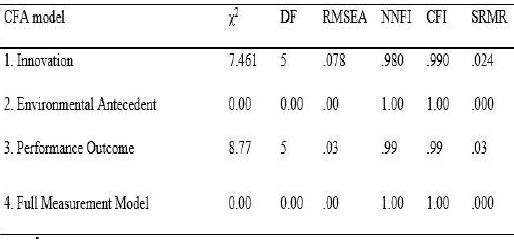
Table 3: Model Fitness